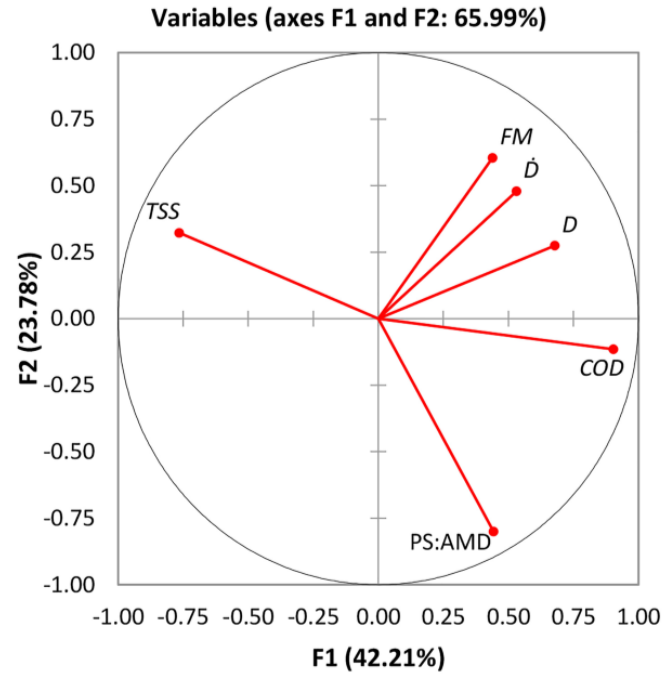
Figure 2. Correlations circle between study variables and factors.